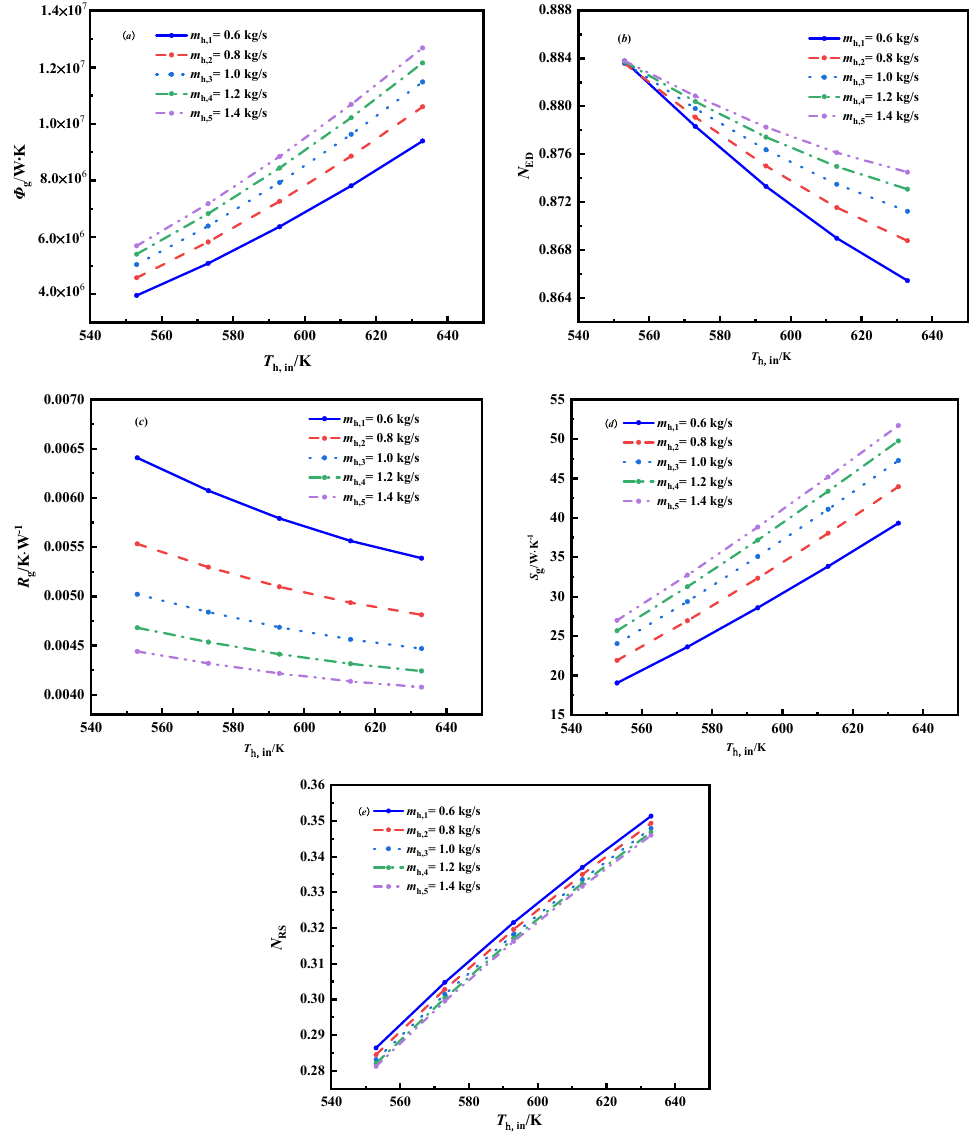
Figure 3. The φ g ( a ), N ED ( b ), R g ( c ), S g ( d ), and N RS ( e ) versus the inlet temperature of molten Figure 3. The 𝜙 ( a ), 𝑁 ED ( b ), 𝑅 g ( c ), 𝑆 g ( d ), and 𝑁 (cid:2902)(cid:2903) ( e ) versus the inlet temperature of molten g salt.